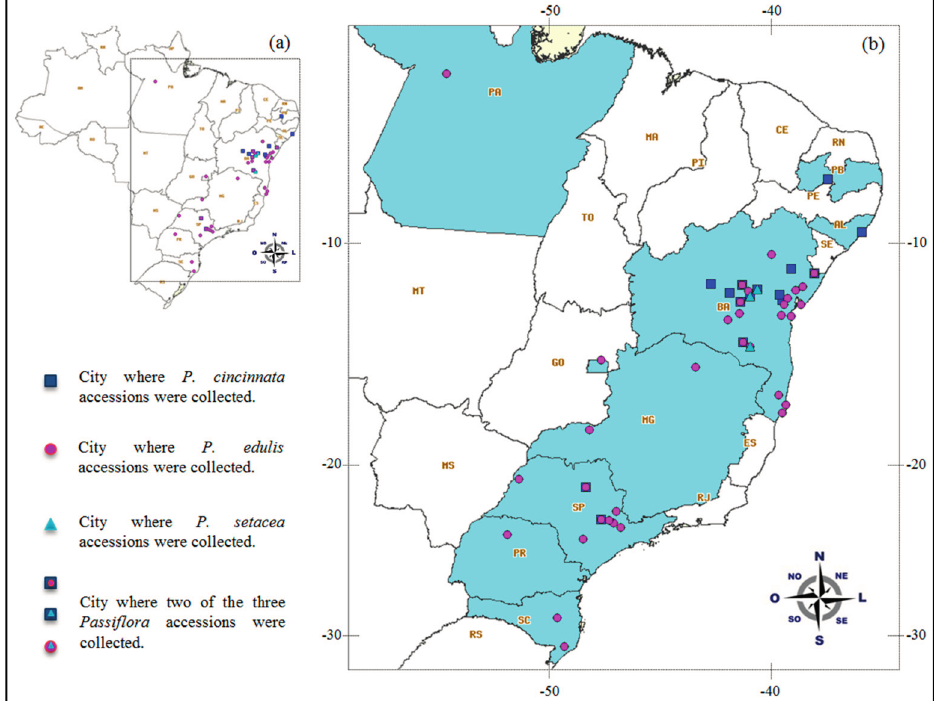
Figure 6. Map of Brazil ( a ) highlighting the geographical areas from which the passion fruit accessions ( Passiflora spp.) were sampled; and ( b ) location of the accessions plotted on a map using the SpeciesMapper tool, which is available at SpeciesLink